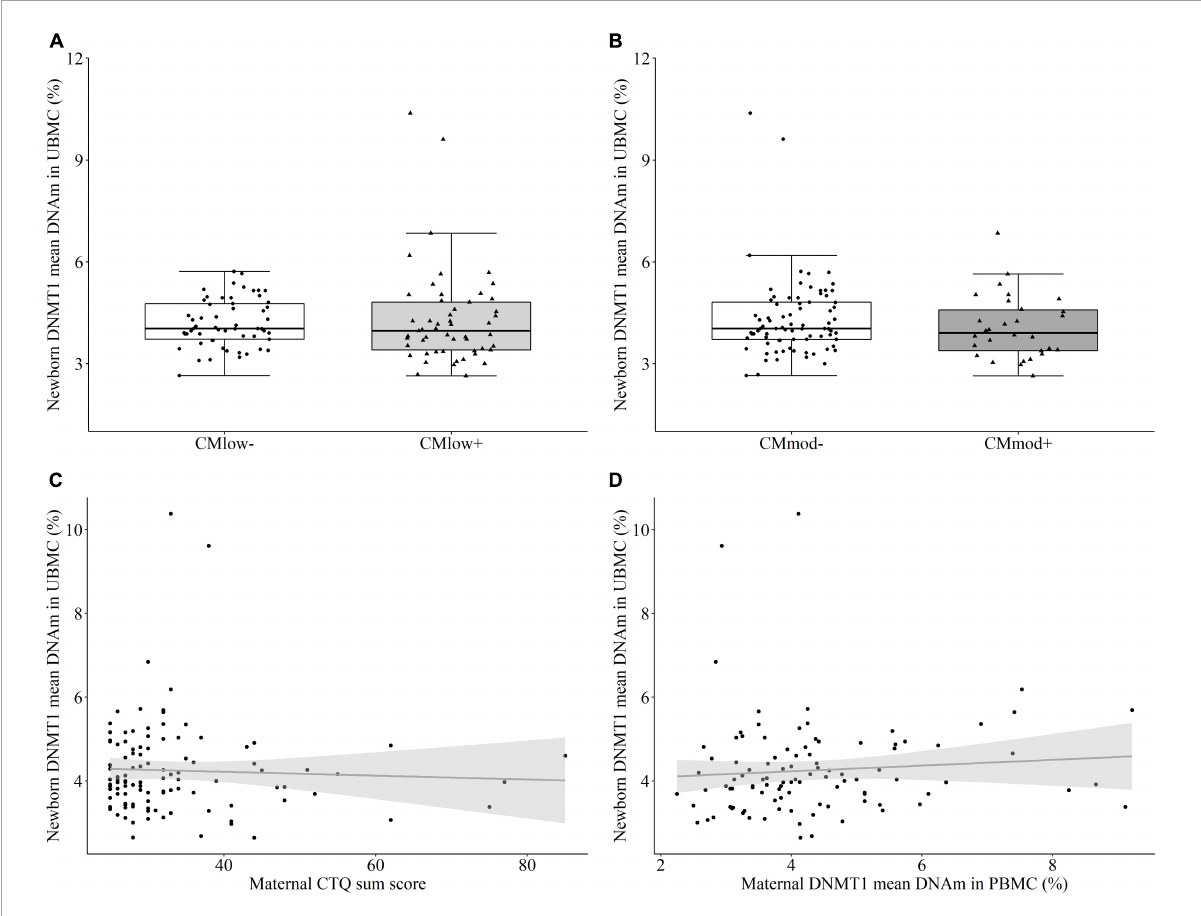
FIGURE5 DNA methyltransferase 1 (DNMT1) mean DNA methylation (DNAm) in umbilical cord blood mononuclear cell (UBMC) of the newborns. (A,B) DNMT1 mean DNA methylation did not differ in newborns with a maternal history of childhood maltreatment (CM) experiences depending on the low cut-off (CM low - versus CM low + ) or moderate cut-off (CM mod − versus CM mod + ). (C) DNMT1 mean DNAm did not have a significant correlation with maternal CTQ sum score ( r s = –0.042, p = 0.662). (D) There was no significant correlation between DNMT1 mean DNAm of mothers and newborns ( r s = 0.146, p =